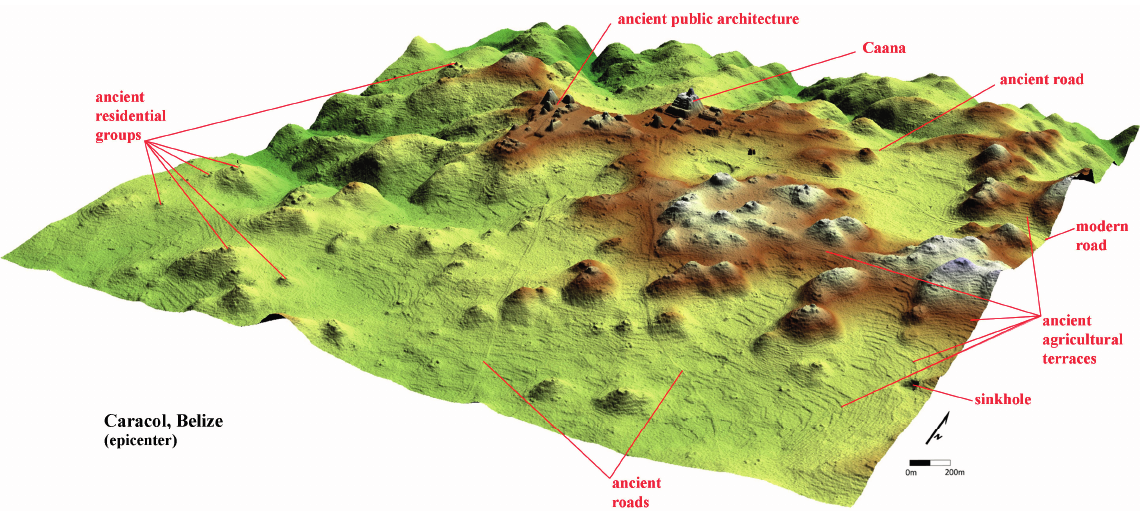
Figure 3. 2.5D LiDAR rendering of the bare earth Caracol epicenter and surrounding residential groups, agricultural terraces, and roadways [20] (Figure 7